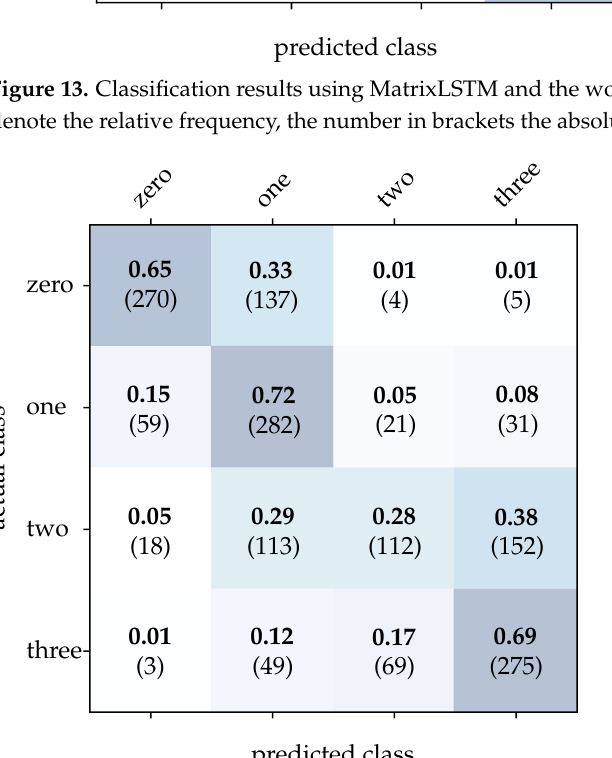
Figure 14. Classification results using the SNN and the wooden balls dataset. The bold values denote the relative frequency, the number in brackets the absolute number of